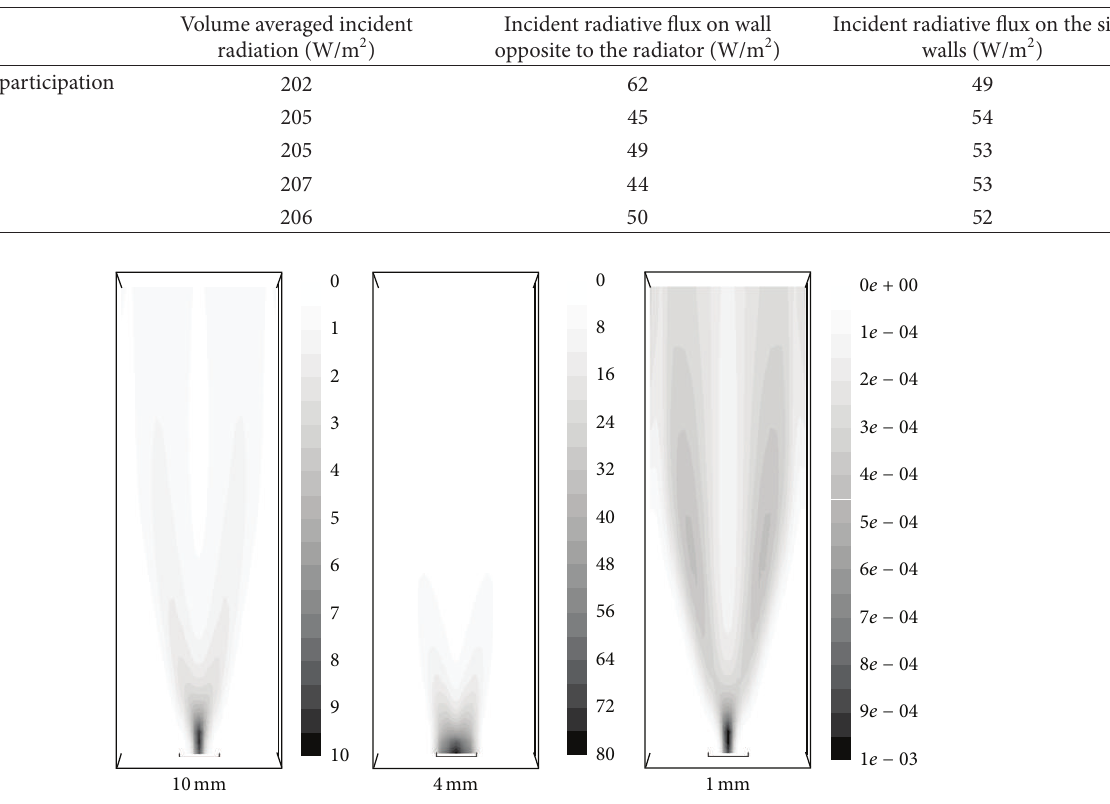
Figure 5: Scattering coefficients (in m −1 ) of the different sized bubbles in the TFM + population balance